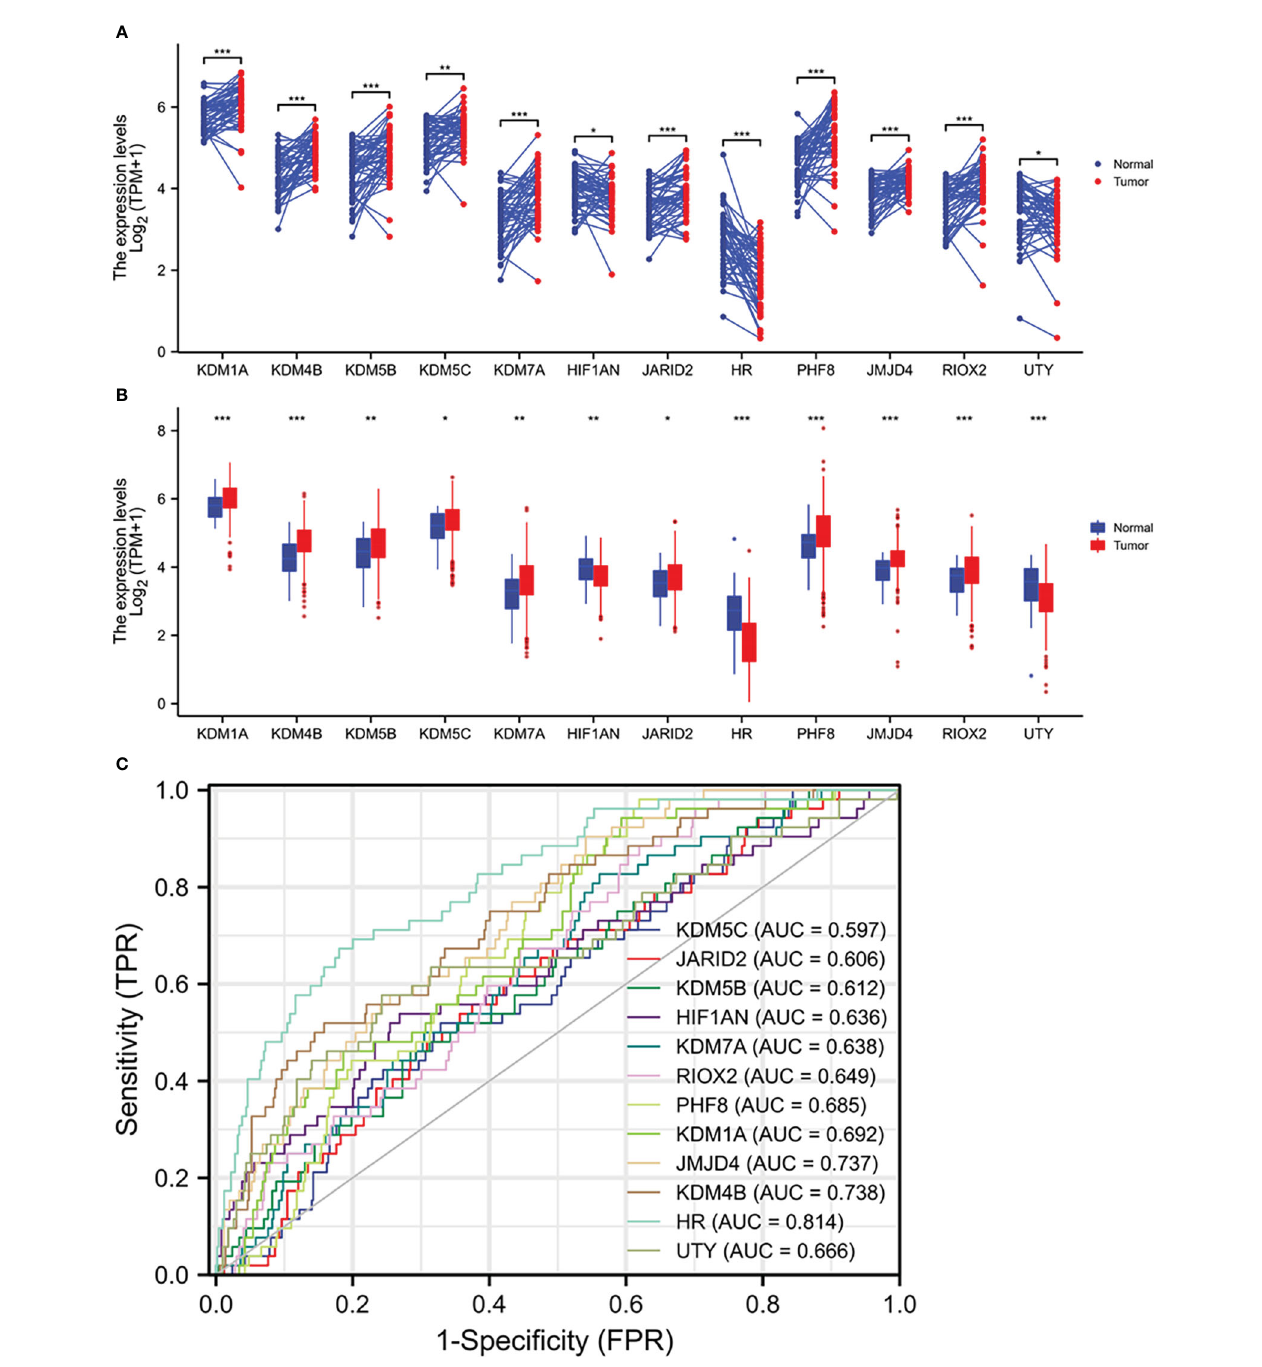
FIGURE 1 Multiple Jumanji domain-containing protein genes are upregulated in prostate cancers. (A, B) Gene expression at the mRNA levels was compared between normal and tumor tissues using the TCGA-PRAD RNA-seq dataset with a case-matched pairwise approach (panel A, n = 52, paired t -test) or group cohort approach (panel B, normal n = 52; tumor = 499, Wilcoxon rank sum test). The asterisks denote different signi fi cance levels, *p < 0.05, **p < 0.01, ***p < 0.001). (C) ROC analysis was conducted for the altered genes distinguishing normal and tumor